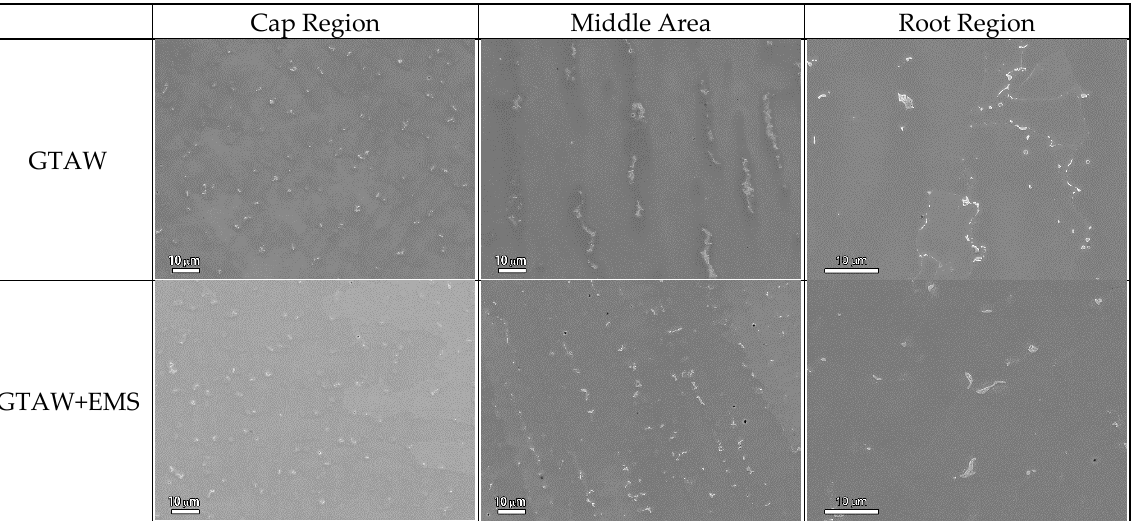
Figure 12. Scanning electron microscope (SEM) micrographs of Alloy 52MSS.